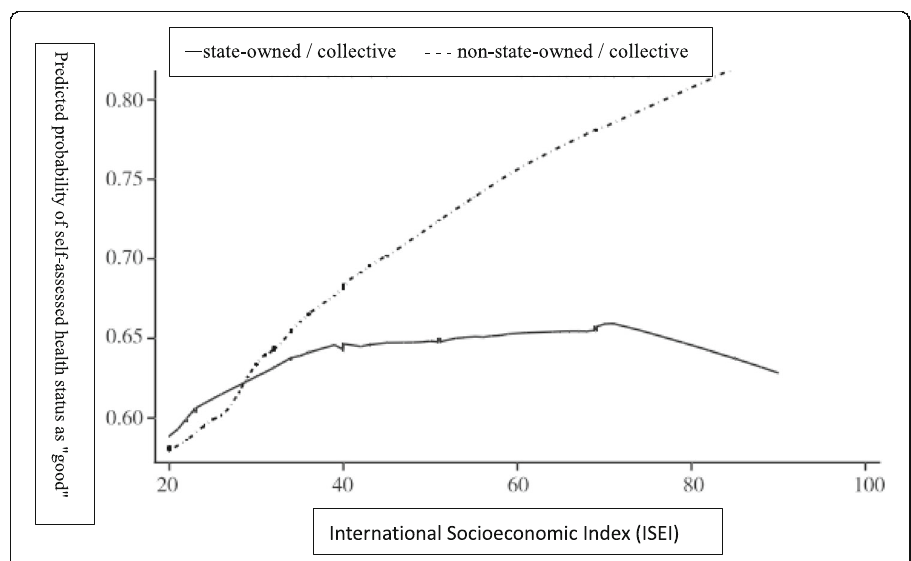
Fig. 1 The interaction effect between occupational status and work unit on self-assessed